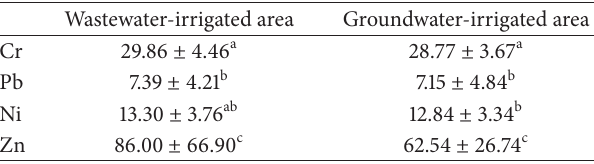
Figure 4: The vertical profiles of heavy metals in soils from wastewater-irrigated and groundwater-irrigated areas. (a) Cr; (b) Pb; (c) Ni; (d) Zn. Table 2: Metal concentrations (mg/kg) in the soil samples collected from wastewater-irrigated and groundwater-irrigated areas ( 𝑛 =